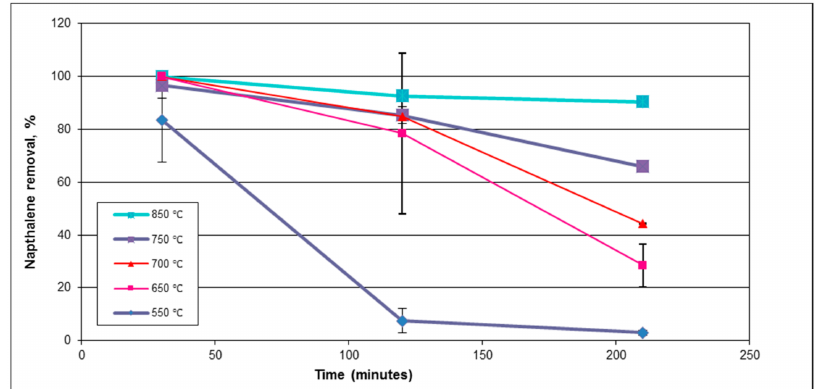
Figure 3. Effect of temperature and time on naphthalene removal efficiency (S/C—5.0, GHSV—